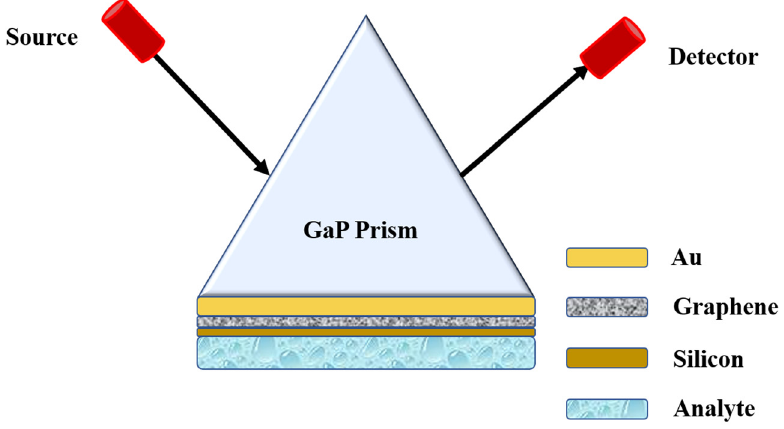
Figure 1. Schematic diagram of the experimental set-up.